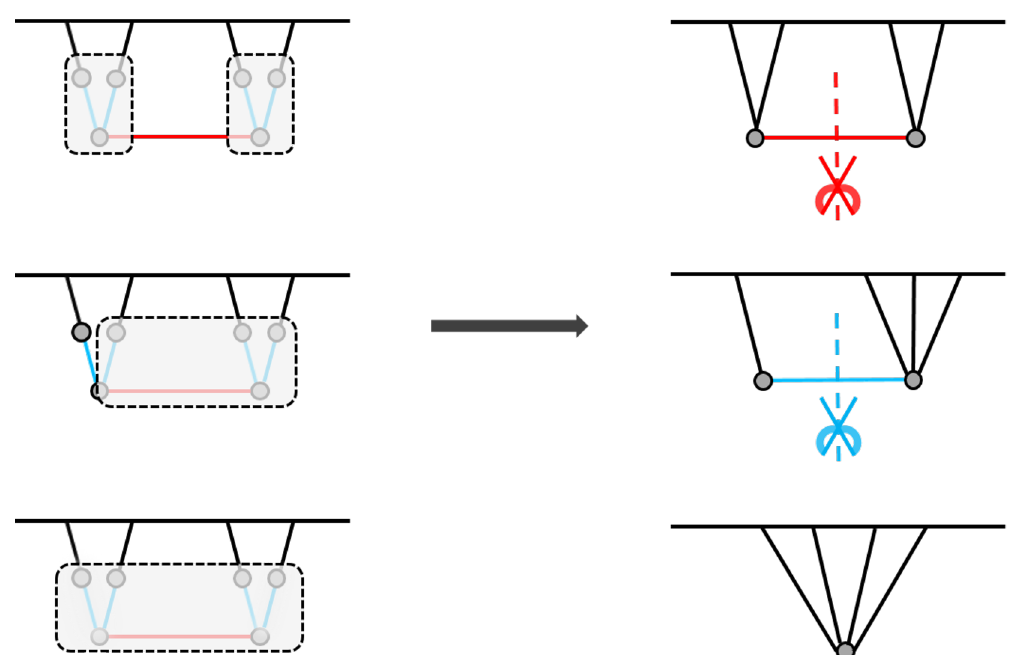
Figure 9 . The strategy of the cutting algorithm for the diagram in figure 8. We traverse all massive propagators and cut one at a time ( (12 , 34) on the first row and (1 , 234) on the second row), while in- tegrating out others as EFTs. At last, we integrate all of them to obtain a total EFT background B